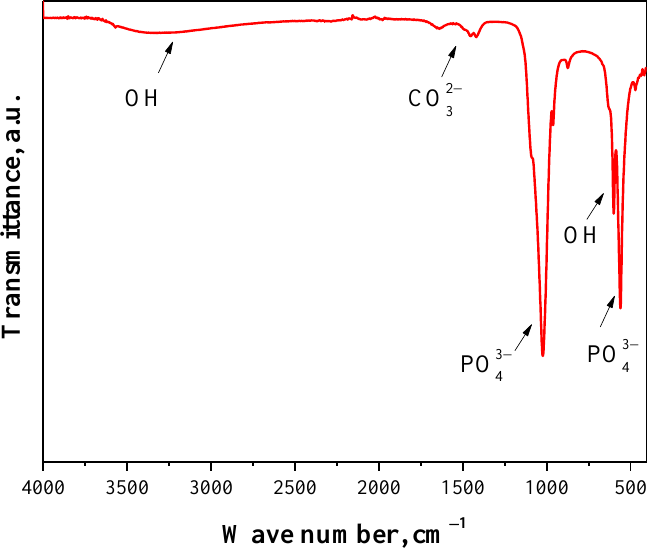
Figure 4. FT-IR spectrum of hydroxyapatite.